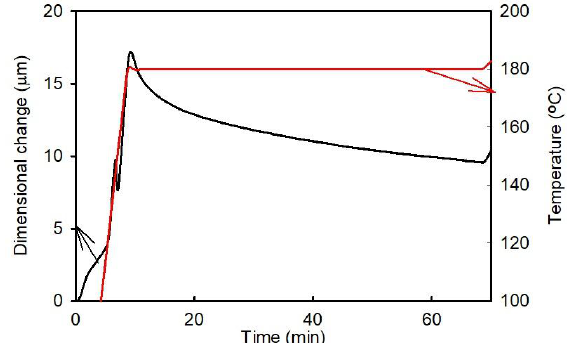
Figure 5. Time dependence of the dimensional changes observed for the A1 sample (FR4 laminate) at 180 °C.